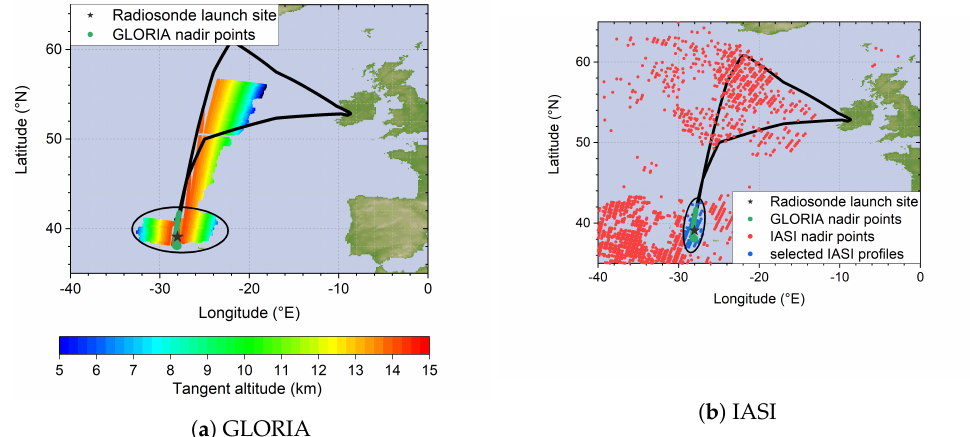
Figure 7. Map projection of the GLORIA limb tangent altitudes and the IASI nadir points. The GLO- RIA limb tangent altitudes in ( a ) are colour coded. The red dots in ( b ) illustrate the IASI nadir positions, while the blue dots indicate the selected IASI profiles. The GLORIA nadir points are indicated by the green dots. The black ovals indicate the measurements that are used for the mean profile comparison and the grey star marks the position of the radiosonde launch